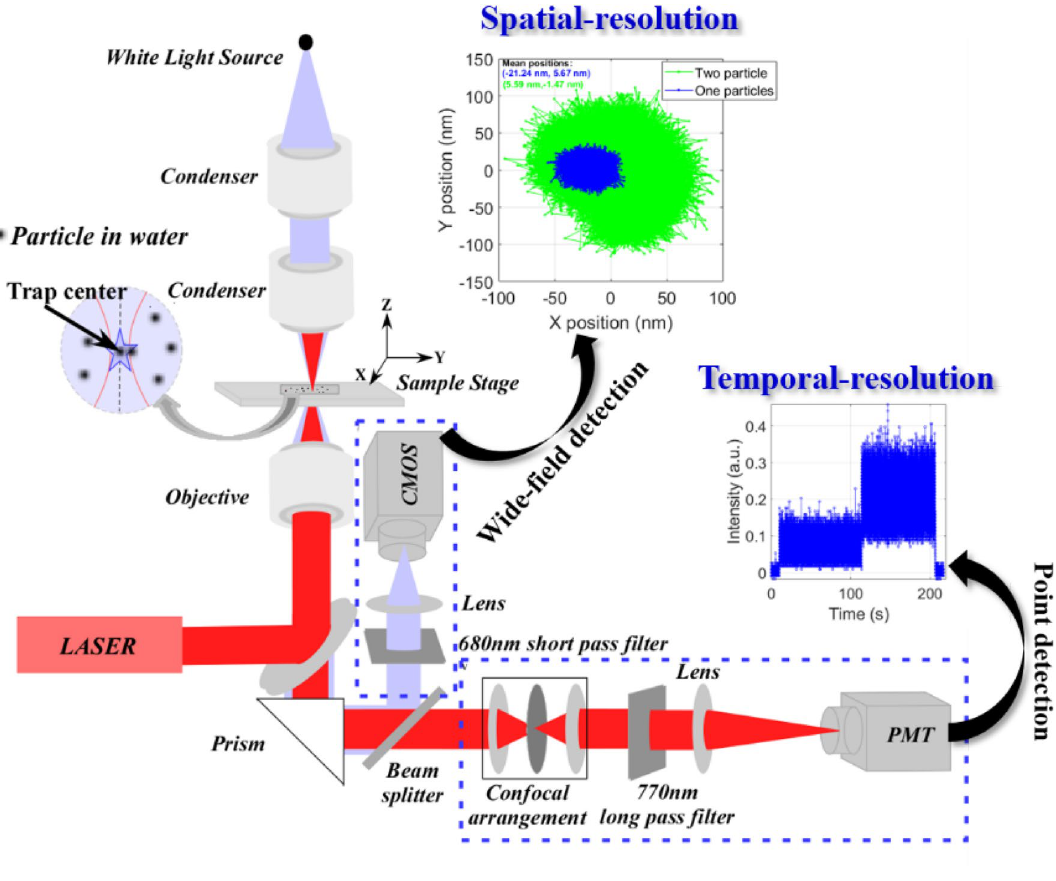
Figure 1. Schematic of the experimental